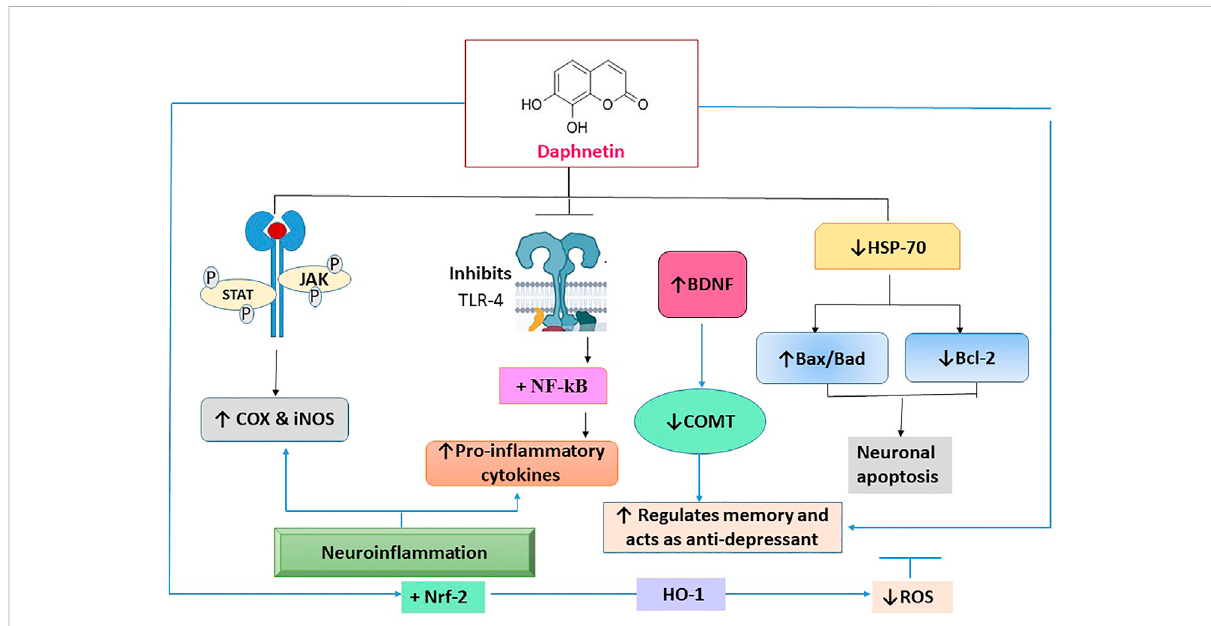
FIGURE 4 The molecular interaction of multiple mediators implicated in the neuroprotective effect of daphnetin. TLR-4: toll-like receptor -4; NF- ĸ β : nuclearfactor- ĸ β